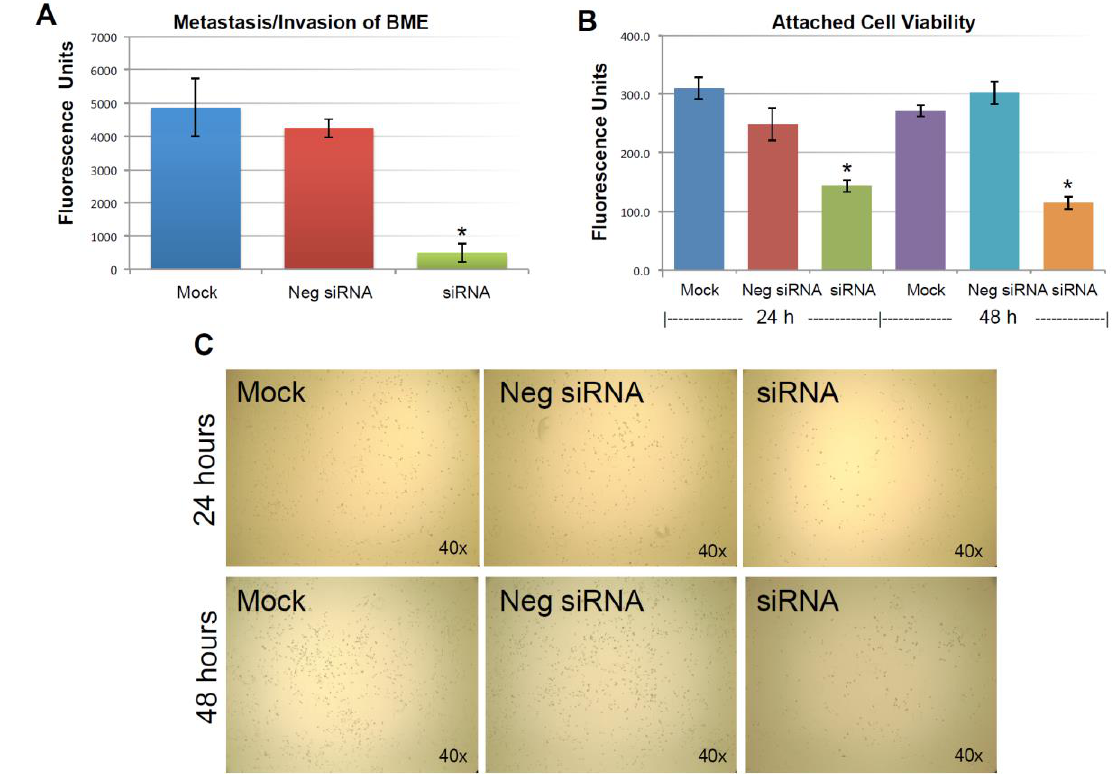
Figure 4. Knocking-down KIAA0100 reduces cell attachment, metastasis and invasion. ( A ) Metastasis/invasion potential were evaluated by the cells’ ability to penetrate BME (Basement Membrane Extract) barrier. Cells able to penetrate the BME barrier were significantly reduced in KIAA0100 knock-down cells, about 90% reduction compared to mock control and 80% compared to cells transfected with negative siRNA (*, p < 0.05); ( B ) amount of cells able to attach onto the culture surface were further examined by the cell viability assay. Significant fewer cells were found to re-attach to the surface from KIAA0100 silenced sample compared to control cells (*, p < 0.05); ( C ) phase-contrast microscope image, less density of the KIAA0100-silenced cells were observed compared to controls cells in 24 and 48 h after treatment.